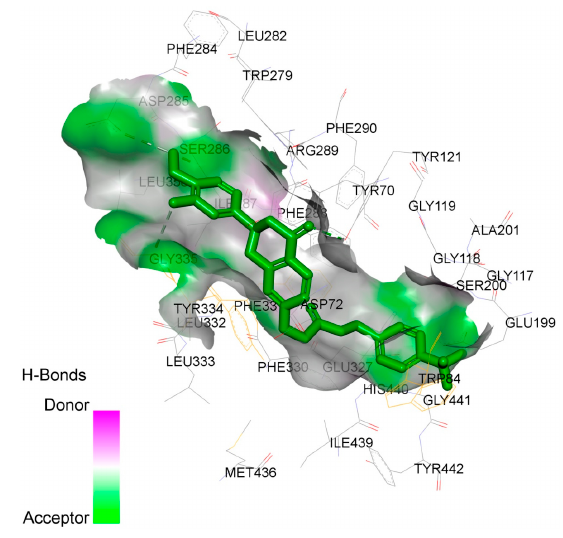
Figure 2. Docking models of compound-enzyme complex: ( 4f )-TcAChE complex.